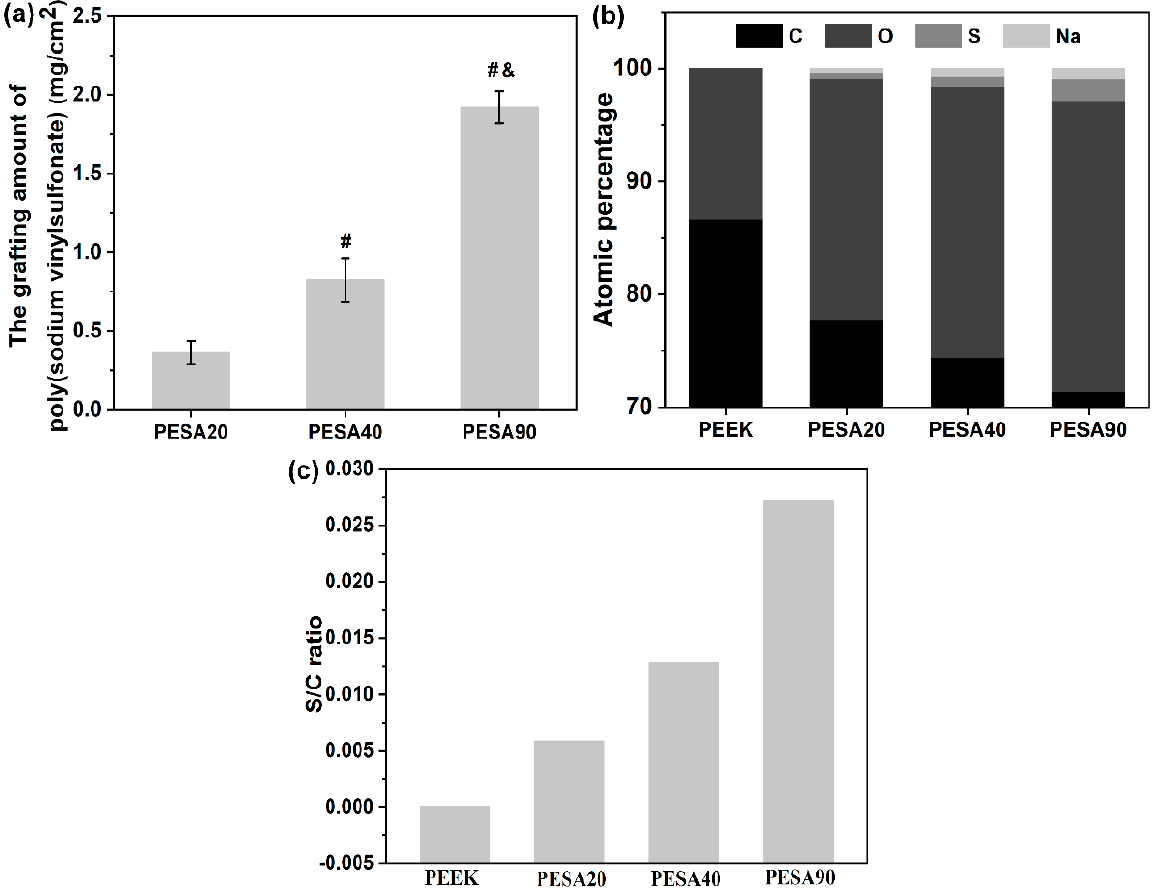
Figure 2. The grafting amount of poly (sodium vinylsulfonate) ( a ) calculated by the mass variation of PEEK before and after surface grafting relative to surface area. Atomic percentage ( b ) and S/C ratio ( c ) obtained from XPS results for PEEK, PESA20, PESA40, and PESA90. Statistically significant differences were indicated by # p < 0.05 compared with the PESA20 and & p < 0.05 compared with the PESA40. All data represent the mean value ± standard deviation ( n = 3 per group).